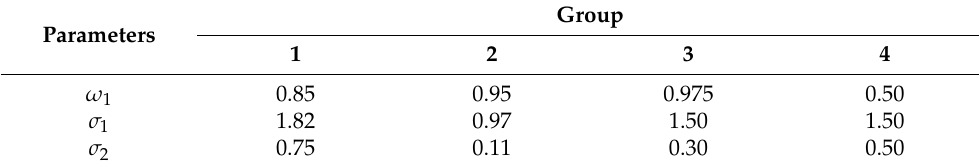
Table 1. Distributions and parameters of the correct parametric model for testing.